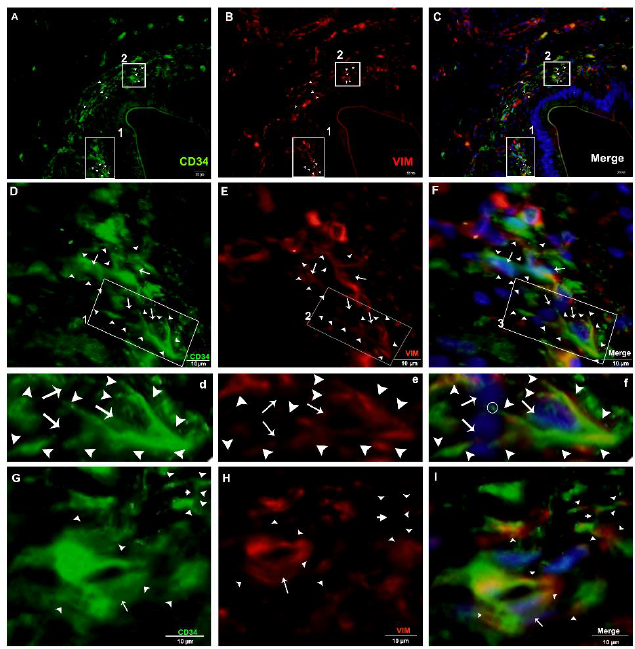
Figure 11. Immunofluorescence-positive TCs in the connective tissue around the interlobular ducts (CD34+, Vimentin+, and merged). ( A – C ) CD34+ (green), Vimentin+ (red), and merged of both showed telocytes and their prolongations abundantly scattered around ducts (arrowheads), respectively. The square-marked area 1 in ( A , B , C ) is enlarged in ( D , E , F ), respectively, and the square-marked areas in ( D , E , F ) are enlarged in ( d , e , f ), respectively. Furthermore, a spindle-shaped (cone-shaped) TC with a nucleus (arrows) and two long process (trajectories) connected with other TC s with their prolongations (arrowheads) can be observed. The square-marked area 2 in ( A , B , C ) is enlarged in ( G , H , I ), each with a triangular-shaped TC with one process. In addition, two Tps with long processes (right-sided) connected by a junction (small arrows), a nucleus (arrows), cell processes (arrowheads), and junctions (small arrows) can also be seen. Scale bar = 20 µm in ( A – C ); scale bar = 10 µm in ( D – F ); scale bar = 10 µm in ( G – I ).